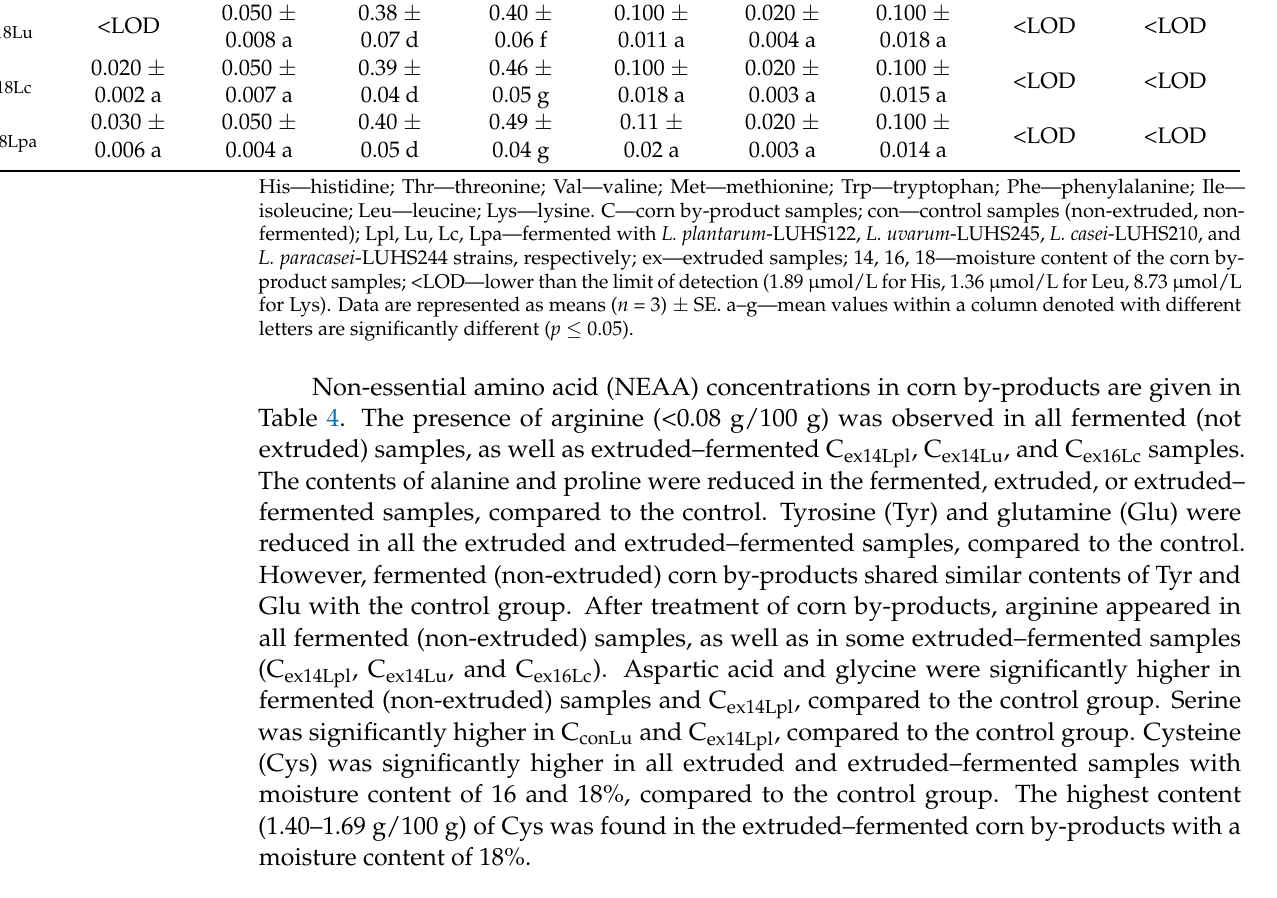
Table 4. Non-essential amino acids mass concentration (g/100g) in corn